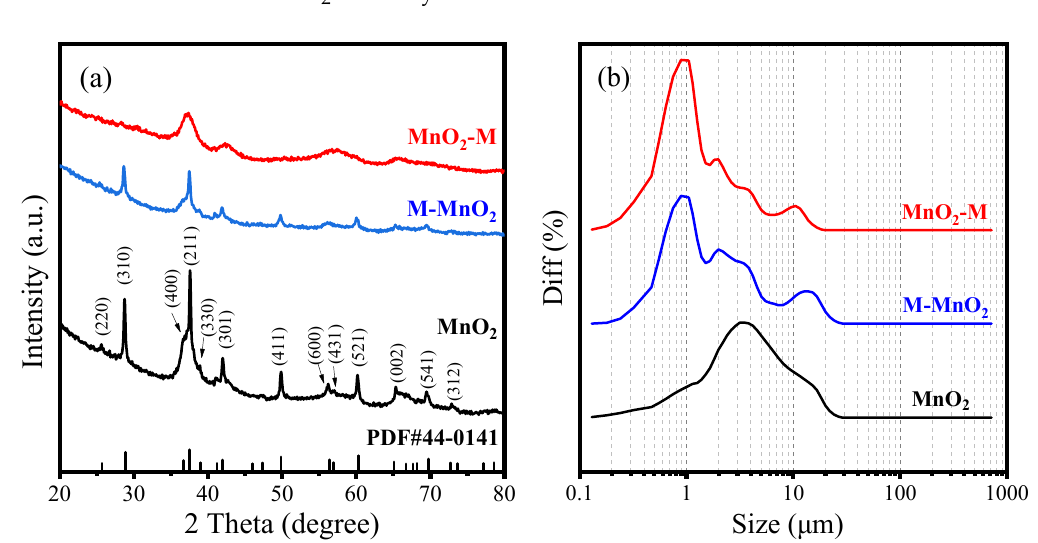
Figure 1. XRD patterns ( a ) and PSD curves ( b ) of the catalysts. Table 1. Physical properties of the catalysts.